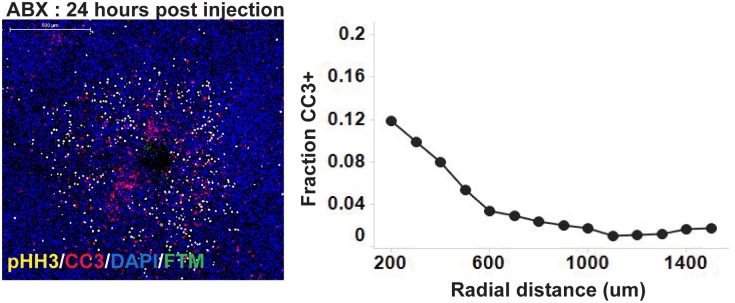
CIVO injection of Abraxane® results in localized mitotic arrest but minimal tumor cell death.MiaPaCa2 tumors (n = 5) were injected using the CIVO device with Abraxane® (ABX) and resected 24 hours post injection. Tissue sections were stained for phospho Histone H3 (pHH3) as a marker of mitotic arrest and cleaved caspase 3 (CC3) as a marker of apoptosis with DAPI as the counterstain. Representative image shows a single site of ABX microinjection with the fluorescent tracking marker (FTM) denoting the site of injection. Representative radial effect curve shows the fraction of CC3+ cells as a function of radial distance from the site of injection.